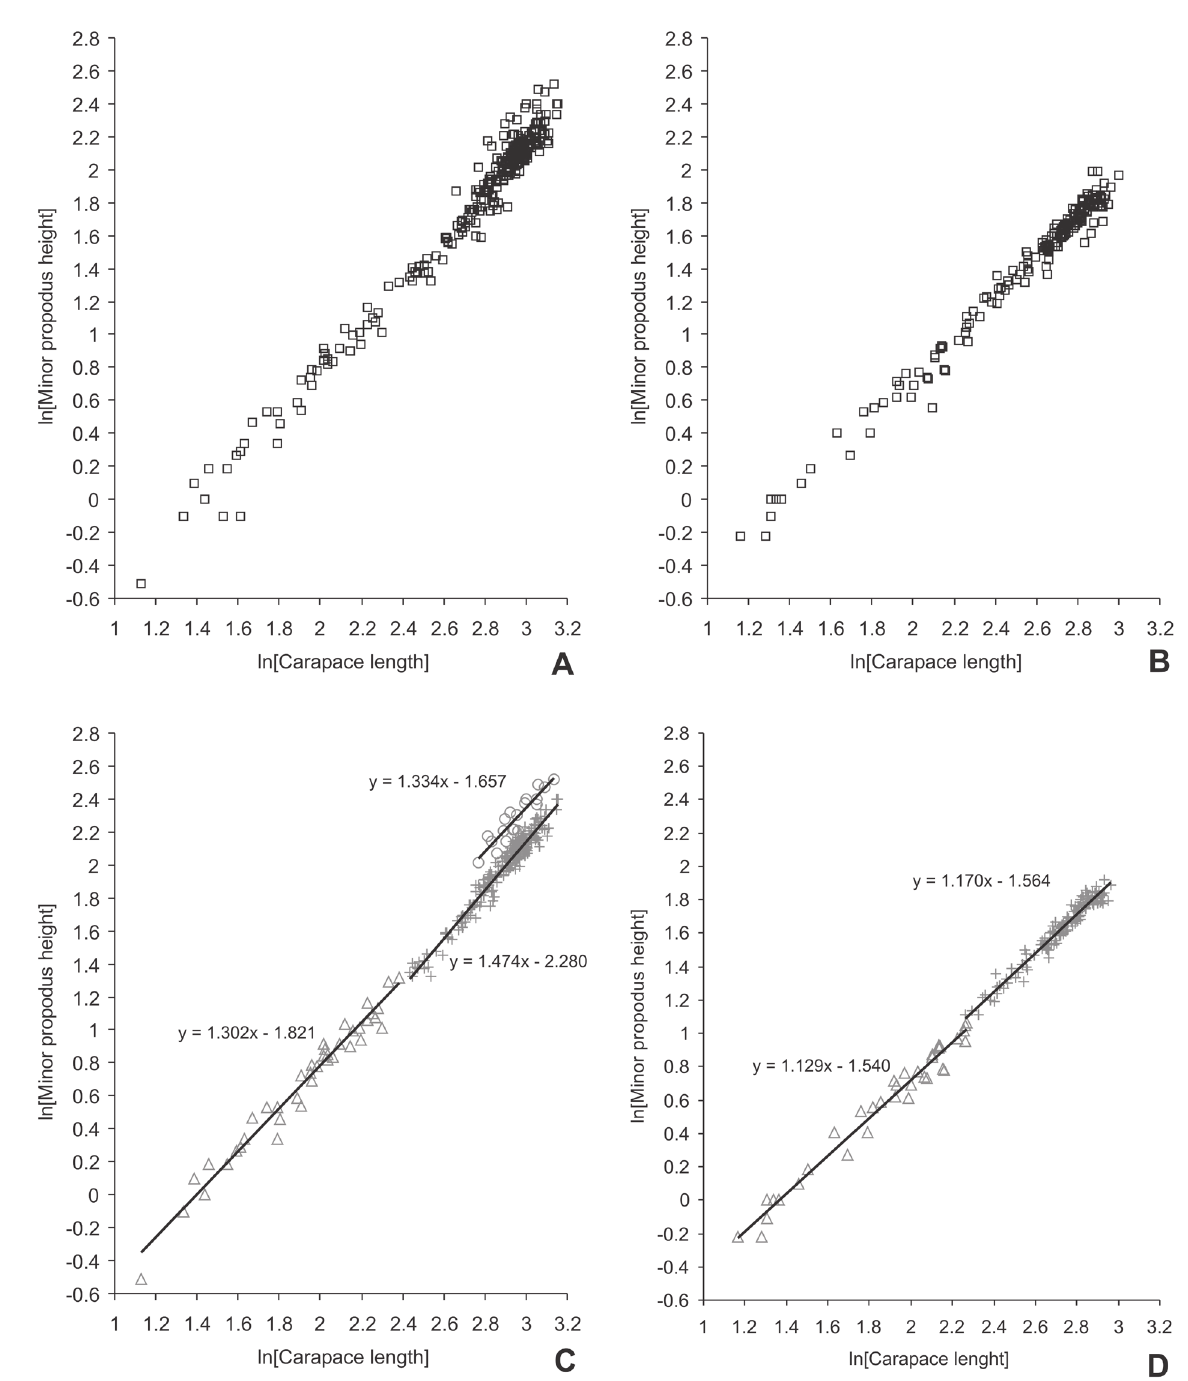
Figure 2. Aegla castro . Scatter plot representations of the ln[minor chela propodus height] vs . ln[capapace length] relationship for males (A) and females (B) prior to life stage group separation (empty squares), and for males (C) and females (D) with groups distinguished. Triangles = juveniles; crosses = adults (females and morphotype I males); circles = morphotype II adult males. Other chelae dimensions exhibited very similar